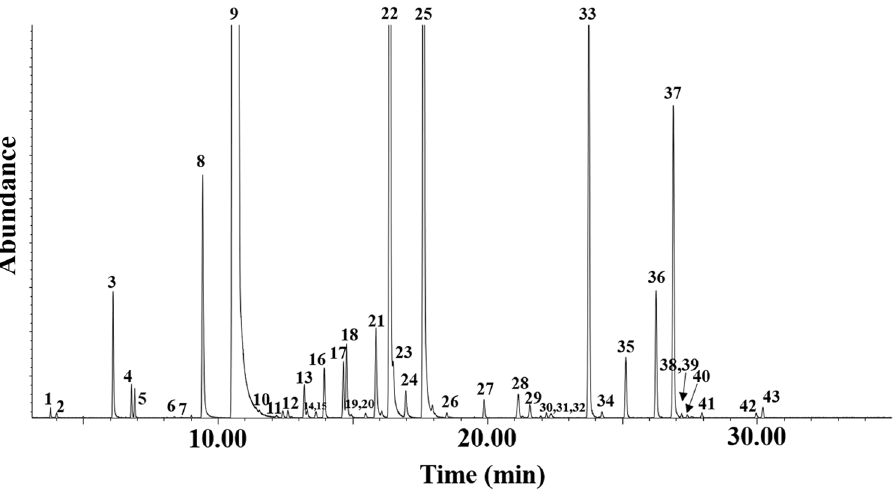
Figure 1. GC–MS total ion current chromatogram of E. beddomei essential oil with identified peaks listed in Table